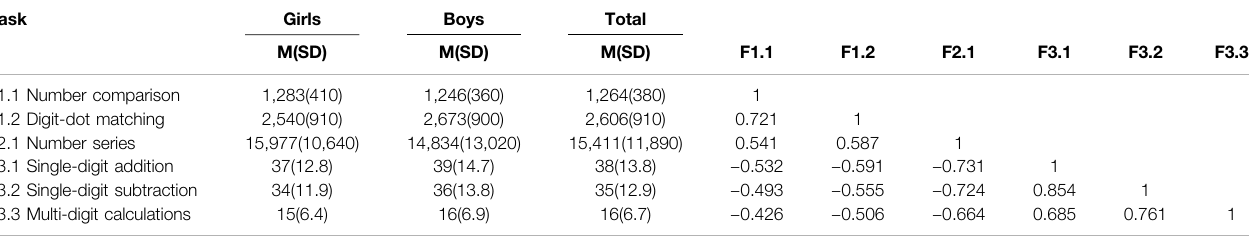
TABLE 2 | Means and standard deviations of and correlations among the basic numerical skills tasks. Task